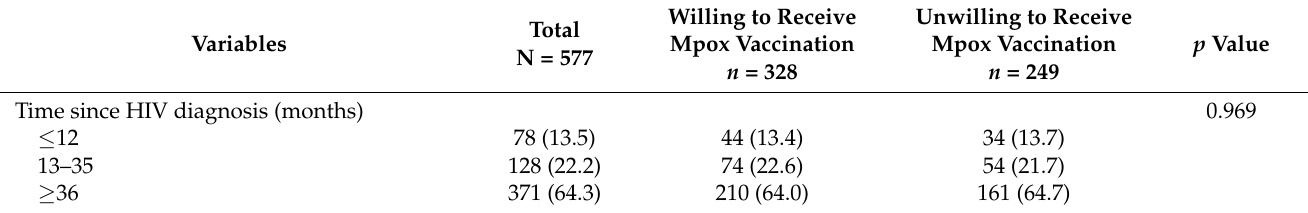
Table 2. HIV status, sexual behaviors, and social contact variables related to willingness to get vaccinated among MSM living with HIV in